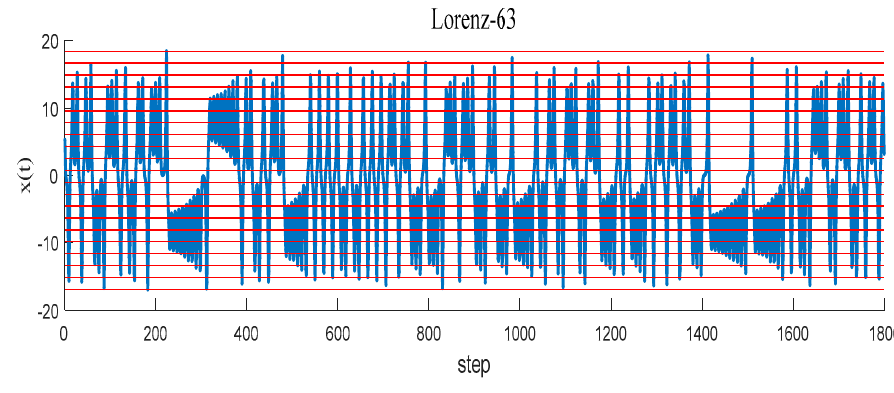
Figure 2. Partition diagram of the Lorenz-63 series.